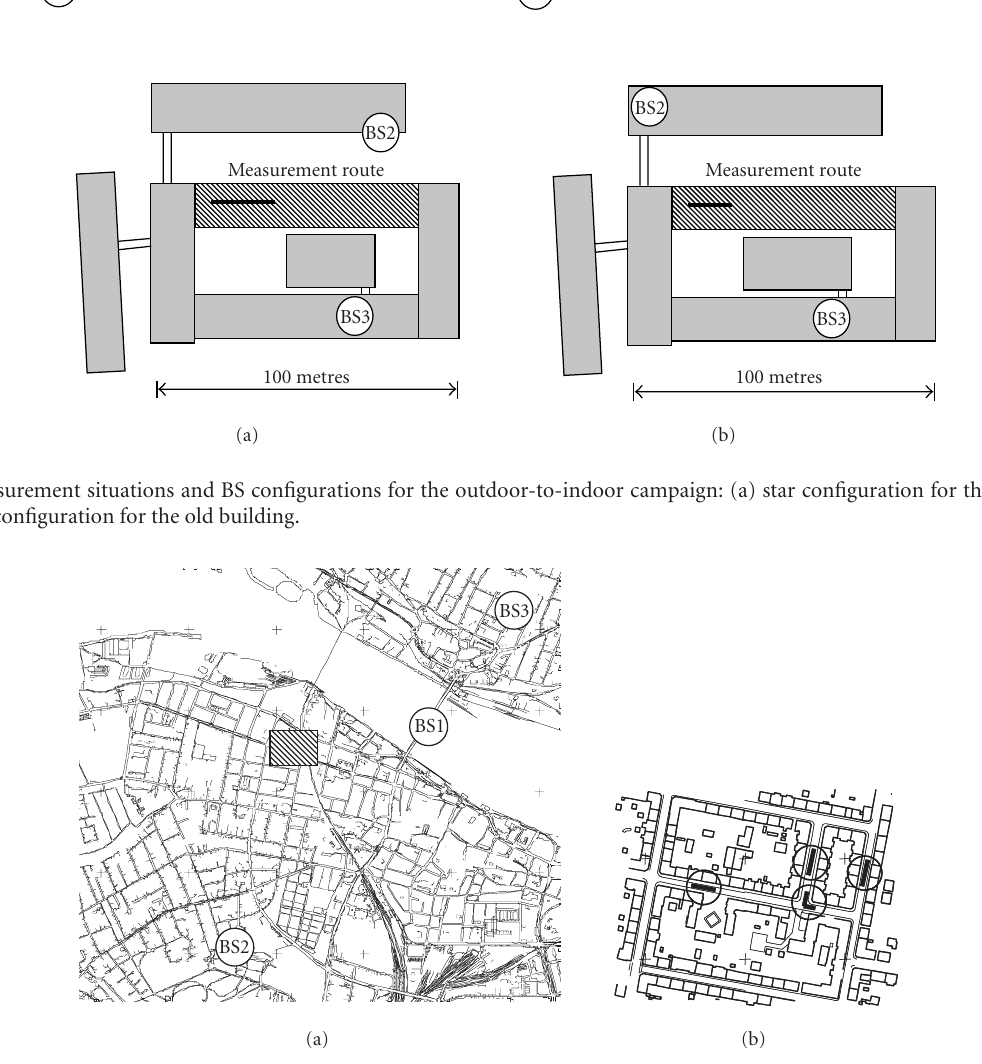
Figure 3: Measurement situation for the outdoor campaign: (a) BSs in the centre of Aalborg with the measurement area shaded (2 . 75 × 2 . 5km 2 ) and (b) enlarged outdoor measurement area with the four measurement trajectories encircled (245 × 180m 2